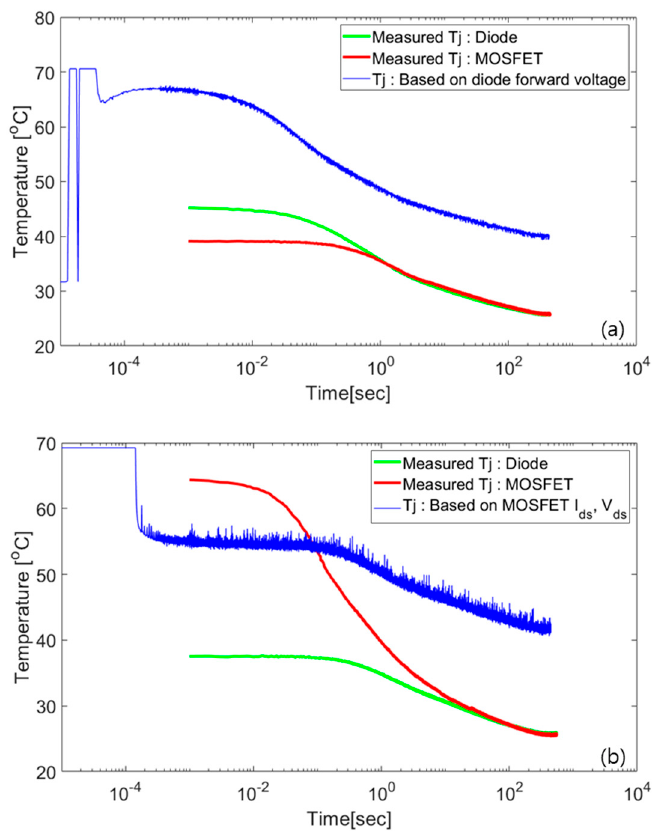
Figure 1. Junction temperature curve during device cooling after heating by a load current of 100 A. Measured junction temperatures of a silicon carbide (SiC) metal-oxide semiconductor field-effect transistors (MOSFET) and SiC diode, compared to ( a ) a temperature-sensitive electrical parameters (TSEP) of the diode forward voltage ( V f ) and ( b ) TSEPs of the MOSFET (drain–source current ( I ds ) and voltage ( V ds )).